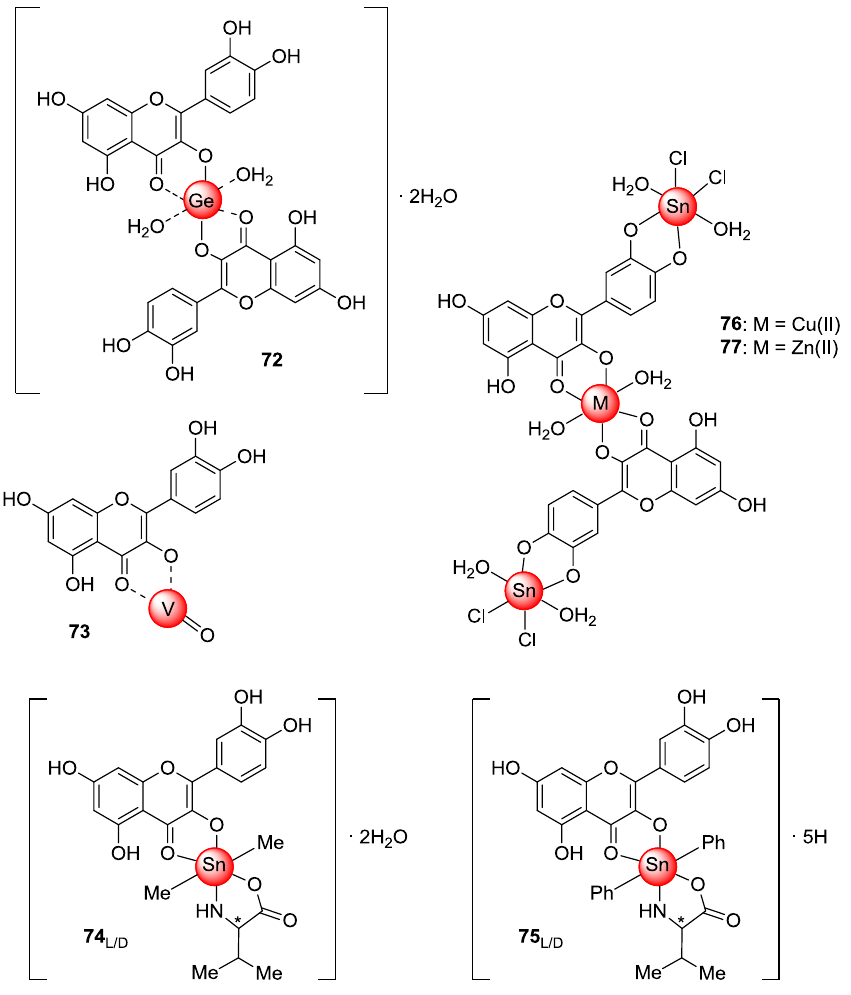
Figure 11. Structures of quercetin-metal complexes 72 – 77 .